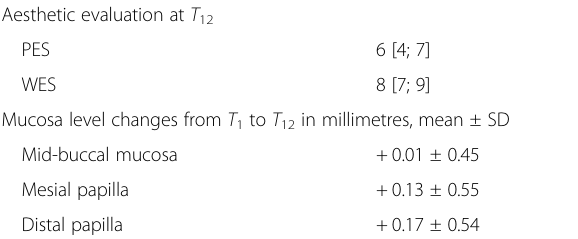
Table 4 Evaluation of the aesthetic outcome at T 12 (PES/WES) and mucosa level change from T 1 to T 12 ( n = 29) Aesthetic evaluation at T 12 PES Mucosa level changes from T 1 to T 12 in millimetres, mean ± SD Mid-buccal